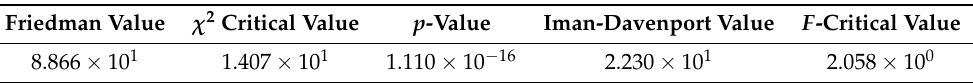
Table 7. Friedman and Iman–Davenport statistical test results summary ( α =